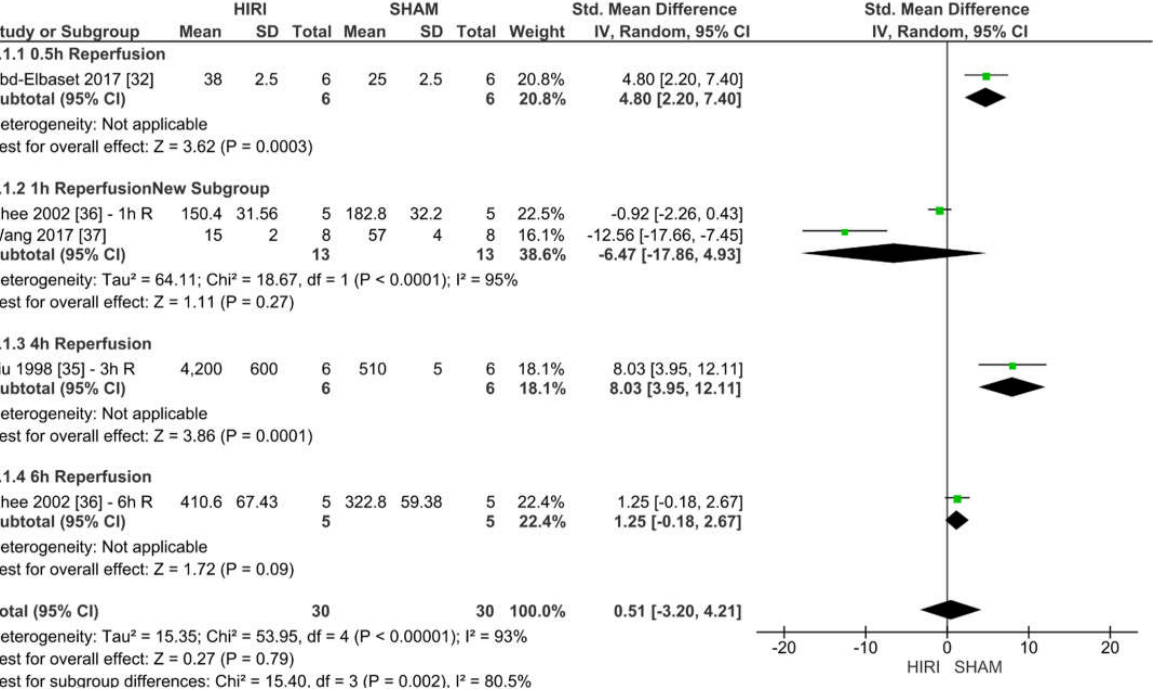
Figure 7. Forest plot of 70% HIRI in rats and 30 min warm ischaemia time grouped by reperfusion time between 0.5 and 72 h.